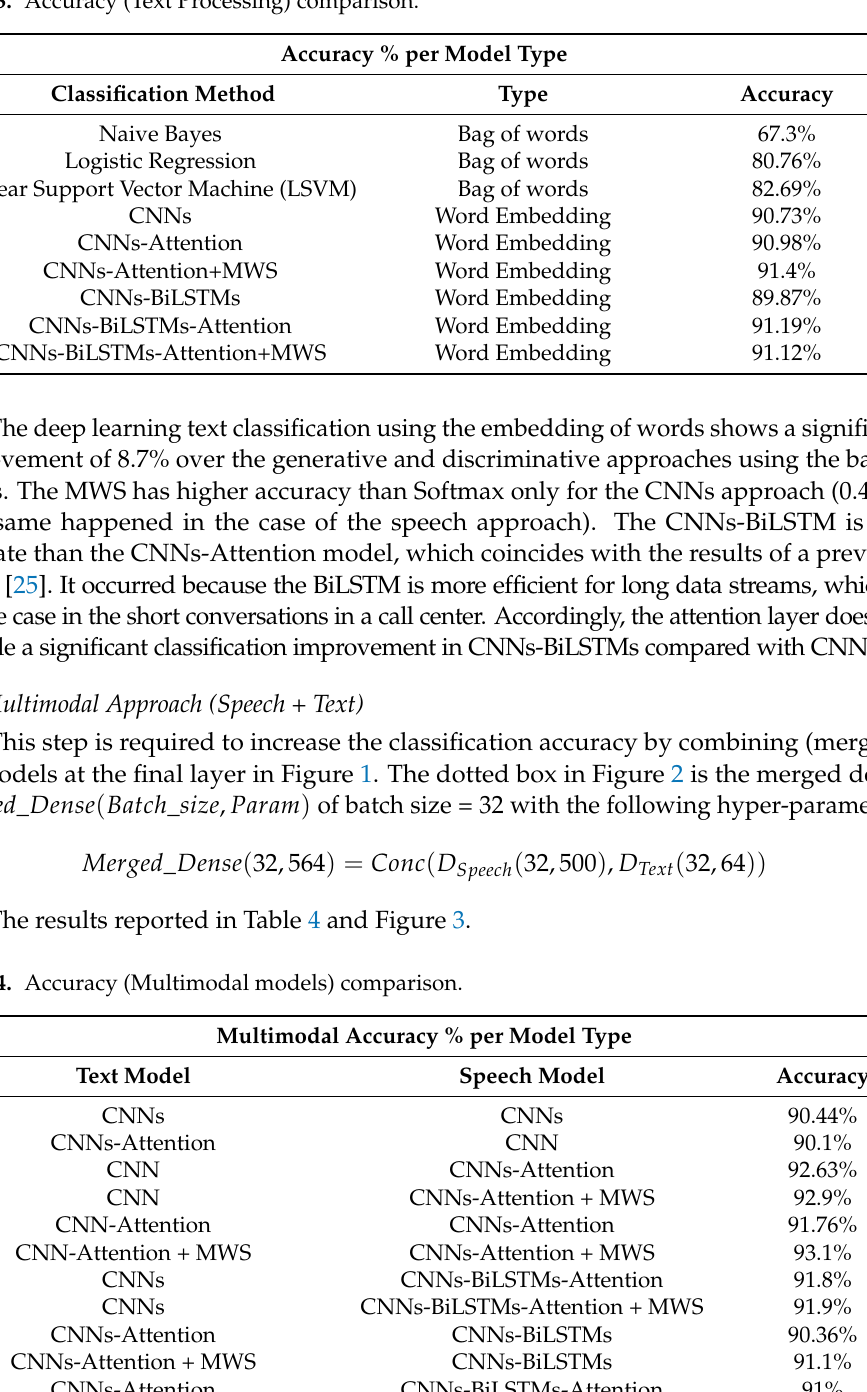
Table 3. Accuracy (Text Processing) comparison.